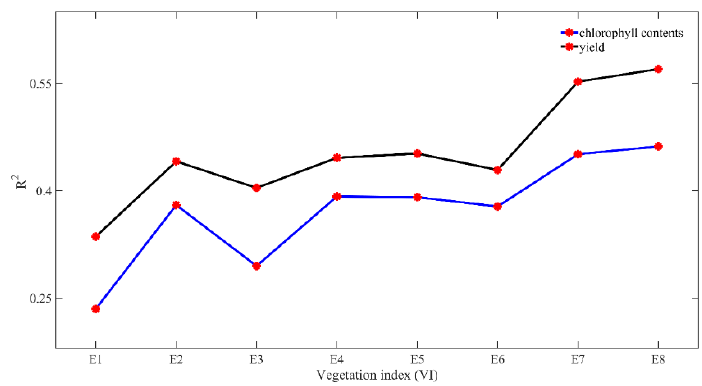
Figure 5. The average of R 2 between VI, chlorophyll contents, and yields of maize. Note: E is short for equation according to Table 2, and E8 refers to the MRBVI.